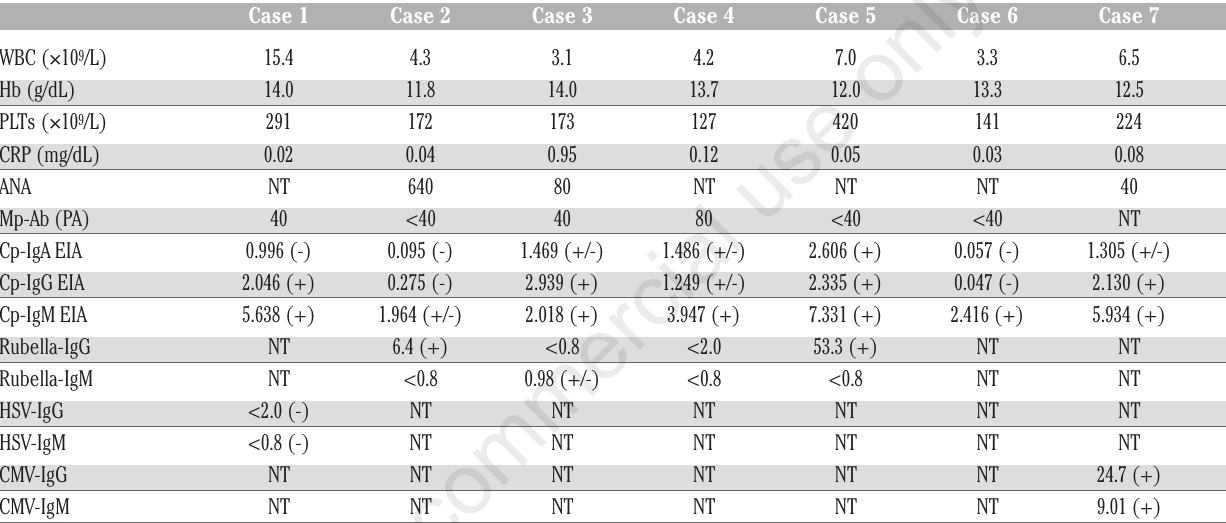
Table 2. Laboratory data of 7 cases of Chlamydia pneumoniae (Cp)-related erythema multiforme.